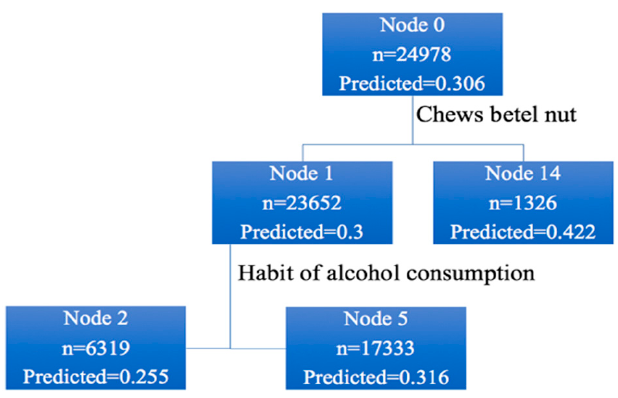
Figure 3. Decision tree analysis results.